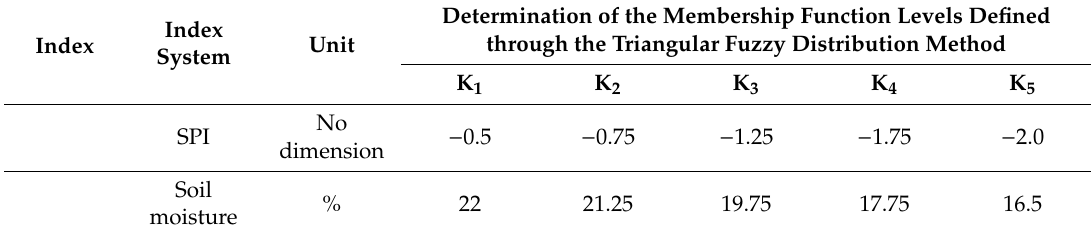
Table 8. Determination of Membership Function Levels corresponding to